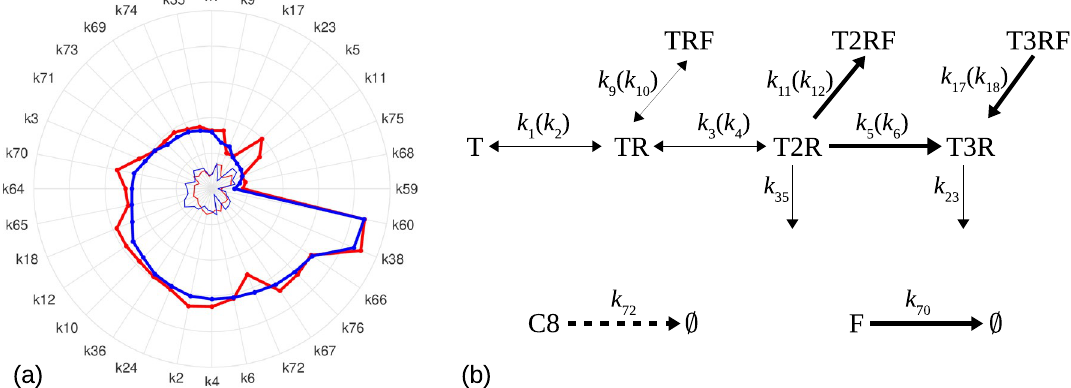
Figure 3. Parameter ranking. ( a ) Comparison of the average values of logarithms of parameters, for sensitive (red) and resistant (blue) cells. Parameters are ordered increasingly on resistant cells values. ( b ) Partial ARRM scheme showing the main differences between the two phenotypes: reactions enhanced (bold arrows) or diminished (dashed arrow) in the sensitive